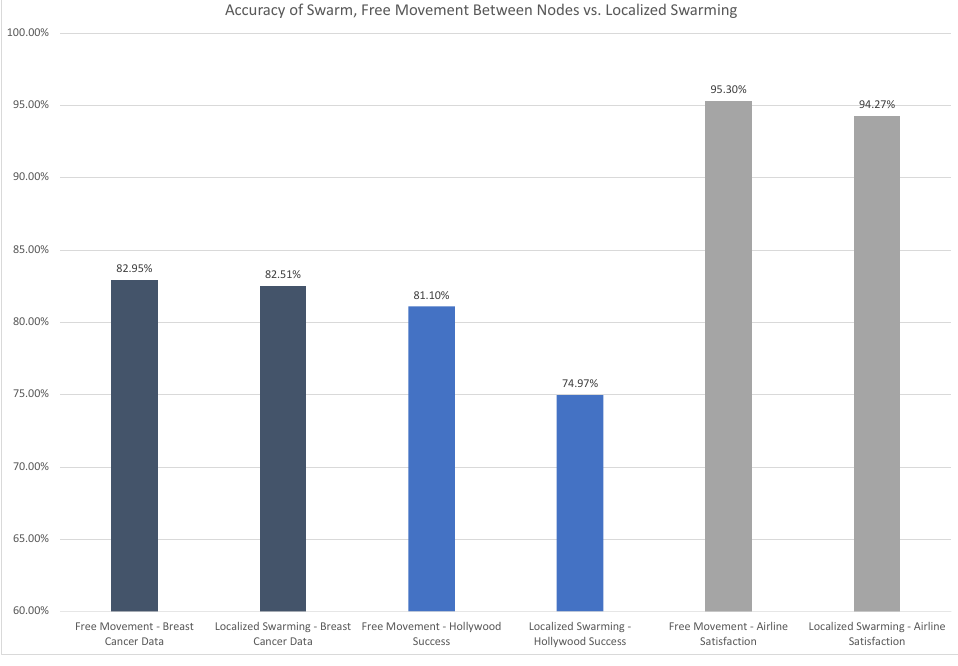
Figure 12. Comparison of prediction accuracy for breast cancer, Hollywood success, and airline passenger satisfaction when allowing free movement between nodes vs. node-local